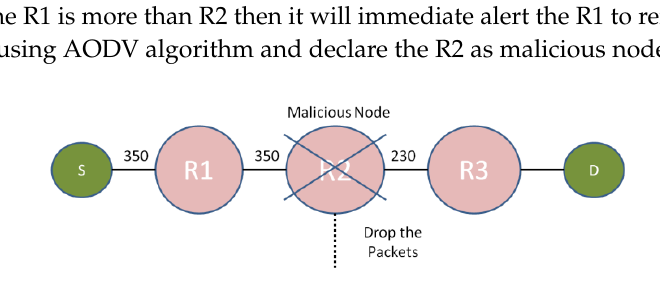
Figure 4. Data transmission in CPS in the existence of a malicious node.